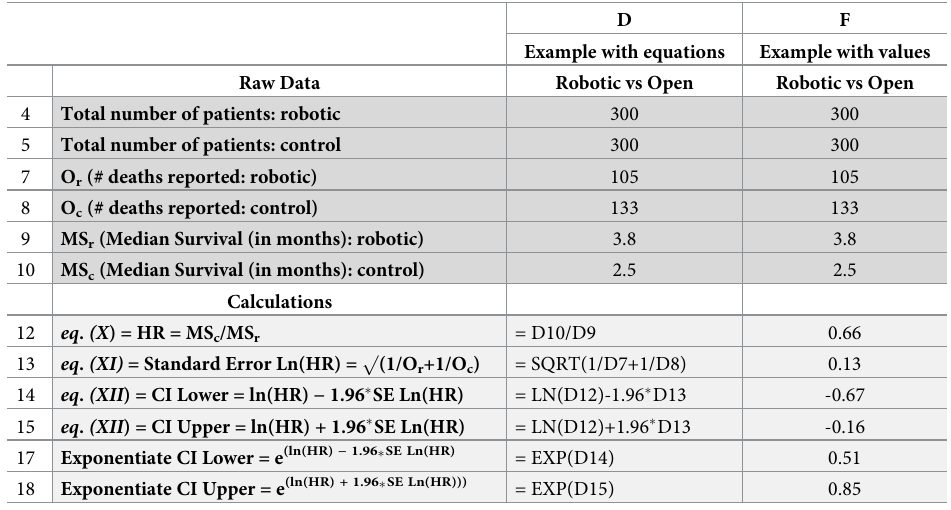
Table 4. Worked example using Method 4b: Hazard ratio calculated using median survival estimates. HR = Hazard Ratio, CI = Confidence Interval, eq. = equation, “Ln” denotes the natural logarithm (log e